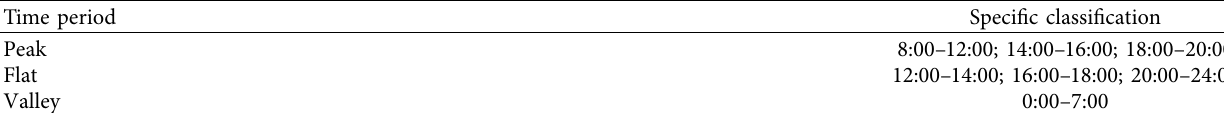
Table 2: Time division for TOU